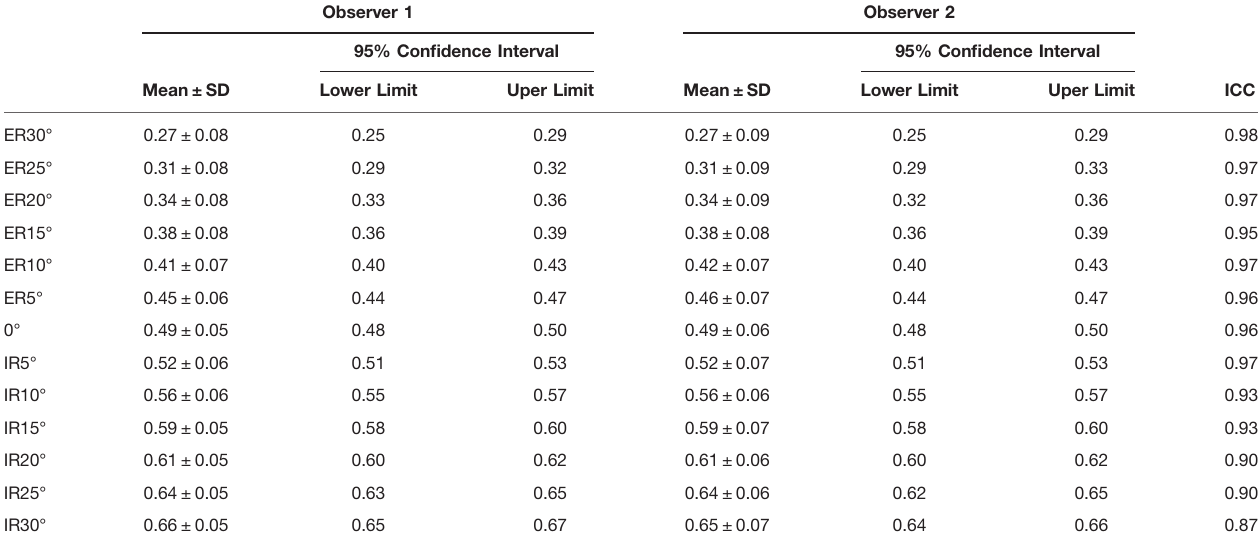
TABLE 1 | Mean±SD, 95% con fi dence intervals, and ICCs for the observers.